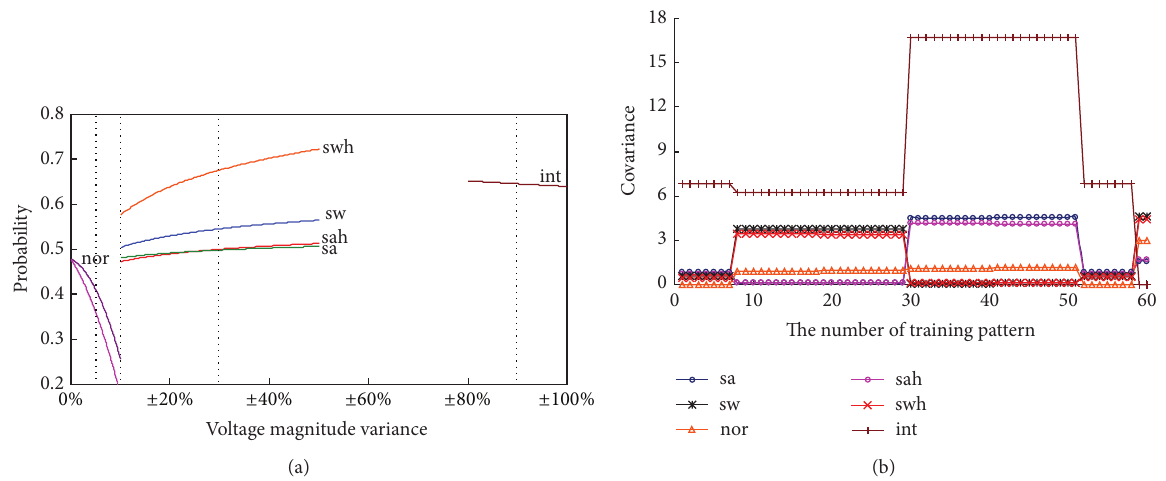
Figure 8: (a) Average probability versus voltage magnitude variant. (b) Covariance versus the number of training pattern for voltage fluctuation phenomena. Note: (1) symbol “+” means voltage magnitude increase and symbol “ − ” means voltage magnitude decay, (2) har : Number 1 ∼ Number 7, sa : Number 8 ∼ Number 18, sah : Number 19 ∼ Number 29, sw : Number 30 ∼ Number 40, swh : Number 41 ∼ Number 51, nor : Number 52 ∼ Number 58, and int : Number 59 ∼ Number